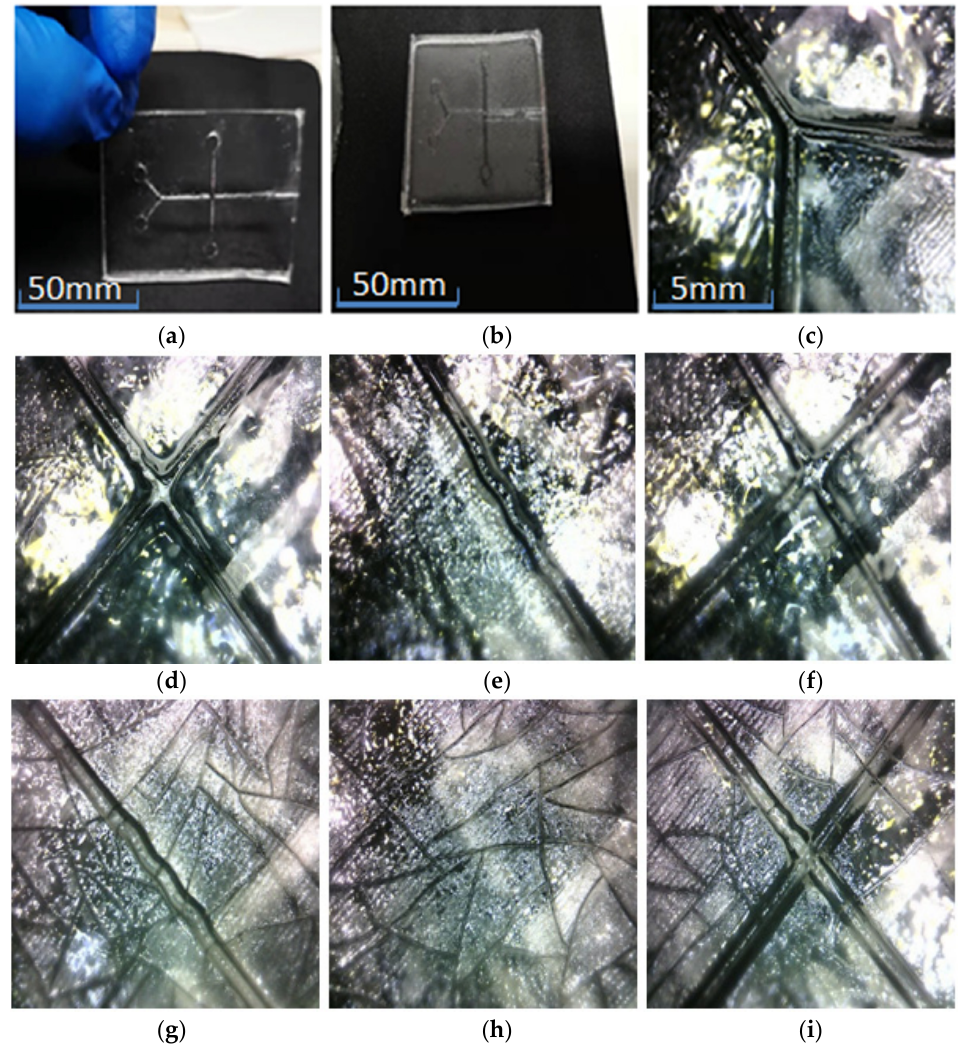
Figure 7. Molding state after drying at 80 °C. The surface-forming effect of the runner shown in the diagrams ( a – f ) is good, without too obvious defects; but there are obvious cracks on the surface of the chip in contact with the mold. The convex mold of the substrate shown in ( g – i ) has obvious cracks during the drying process.